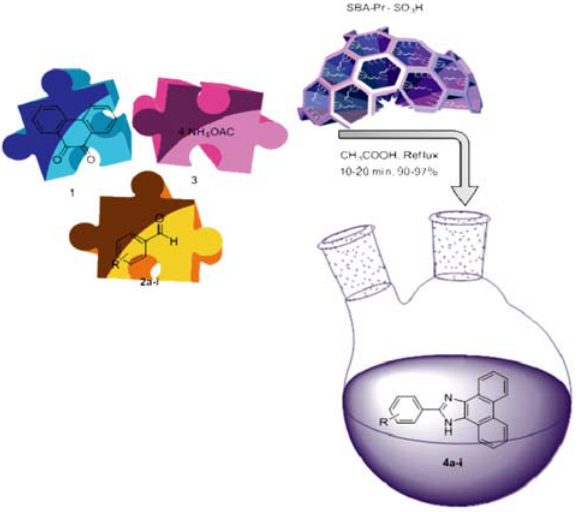
Scheme 2. The proposed mechanism for the synthesis of 2,4,5- trisubstituted phenanthroimidazoles ( 4